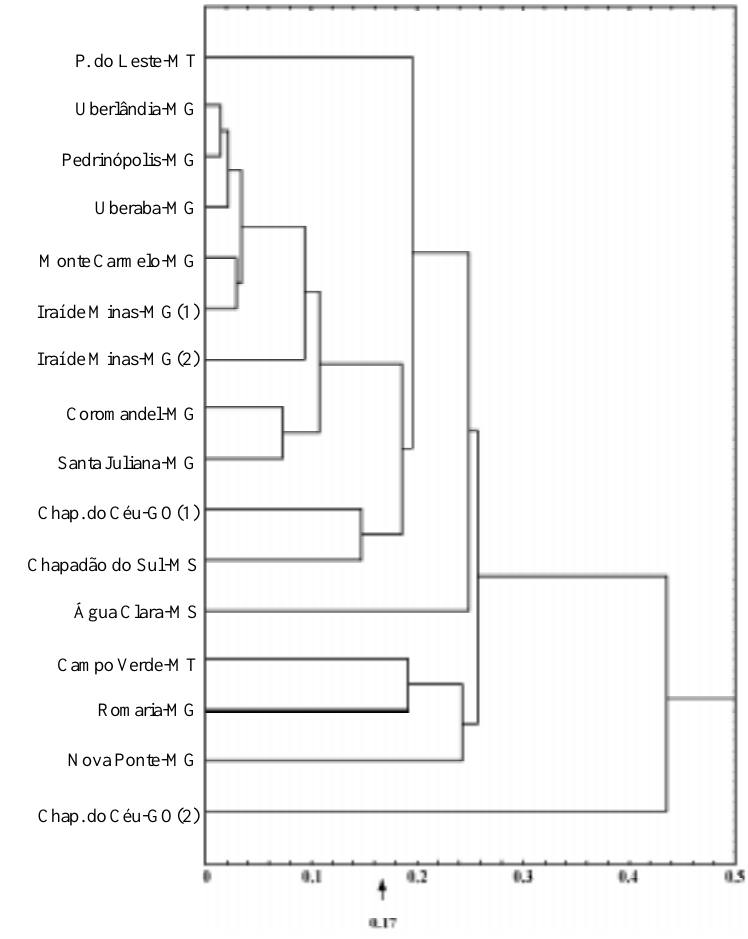
Figure 1 - UPGMA dendrogram generated with genetic distances as percent disagreement for 16 different popu- lations of Heterodera glycines . These genetic distances were calculated with 68 RAPD markers obtained with 12 different random